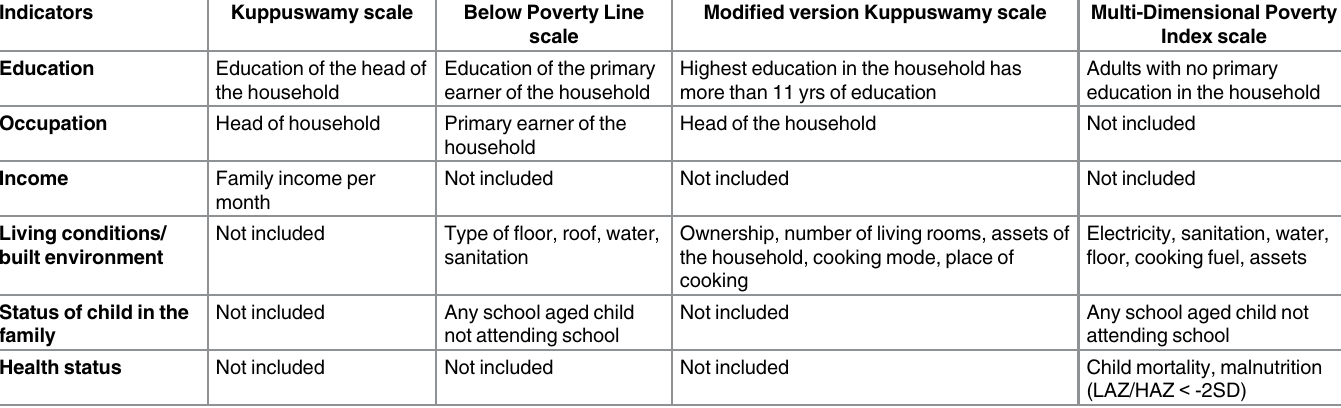
Table 1. Indicator variables used in the Kuppuswamy, Below Poverty Line, modified Kuppuswamy scales and the Multi-Dimensional Poverty Index scales.